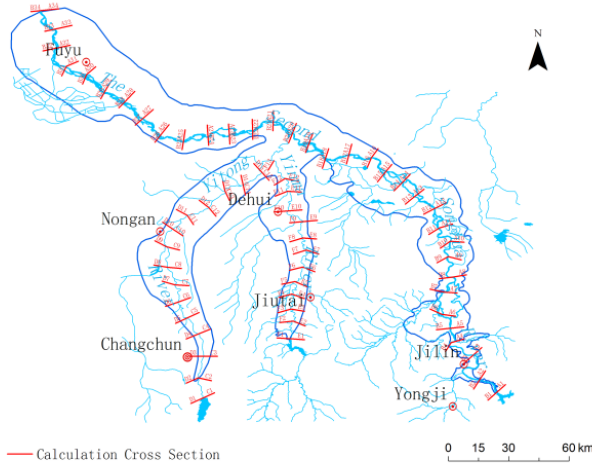
Figure 13. Cross sections for calculation of hydraulic gradients.